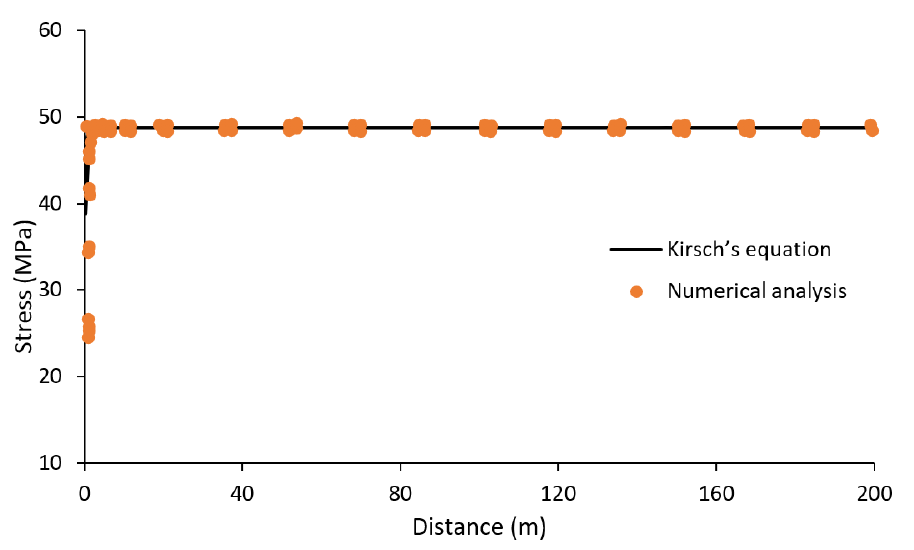
Figure 18. Axial stress distribution obtained from numerical modeling and the analytical solution of Kirsch’s equation around the wellbore-D in the Azar oilfield.